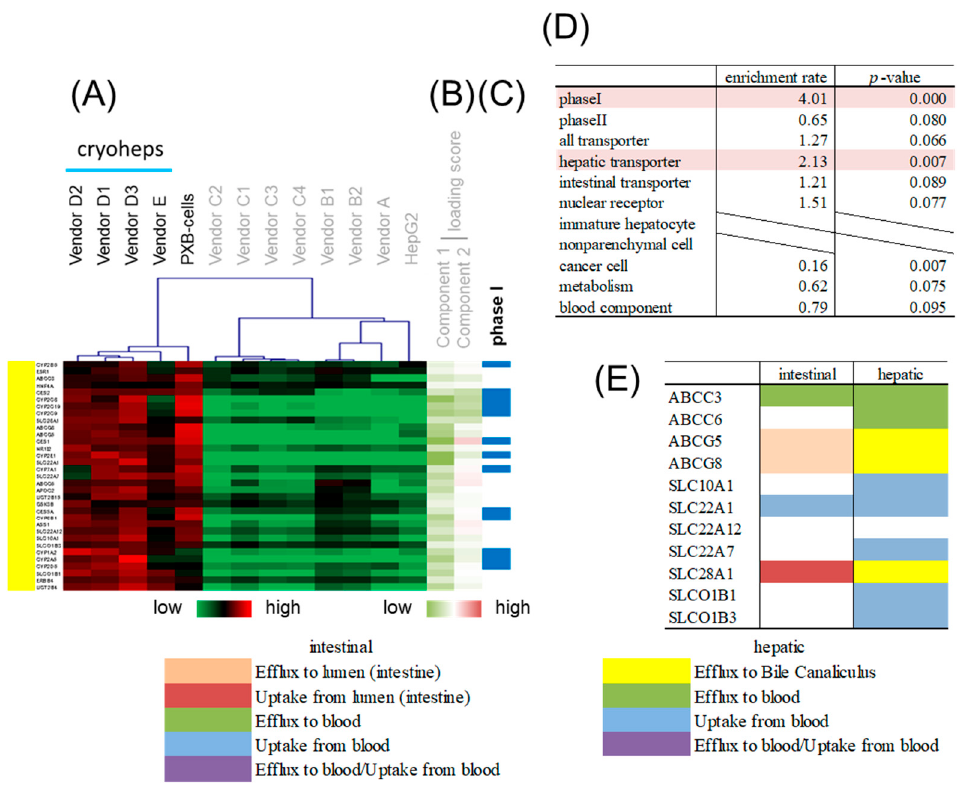
Figure 6. Enrichment analysis of the yellow branch. ( A ) Heatmap patterns. ( B ) PC 1 and 2 scores. Red lines exhibit plus scores, and green lines exhibit minus scores. ( C ) The blue lines exhibit genes related to drug metabolism phase I enzymes. ( D ) Enrichment rates and p -values from the chi-squared test of different gene categories. The highlighted categories are significantly enriched. ( E ) Transporter genes. Hepatic and intestinal transporter genes are classified according to function, as shown by color.